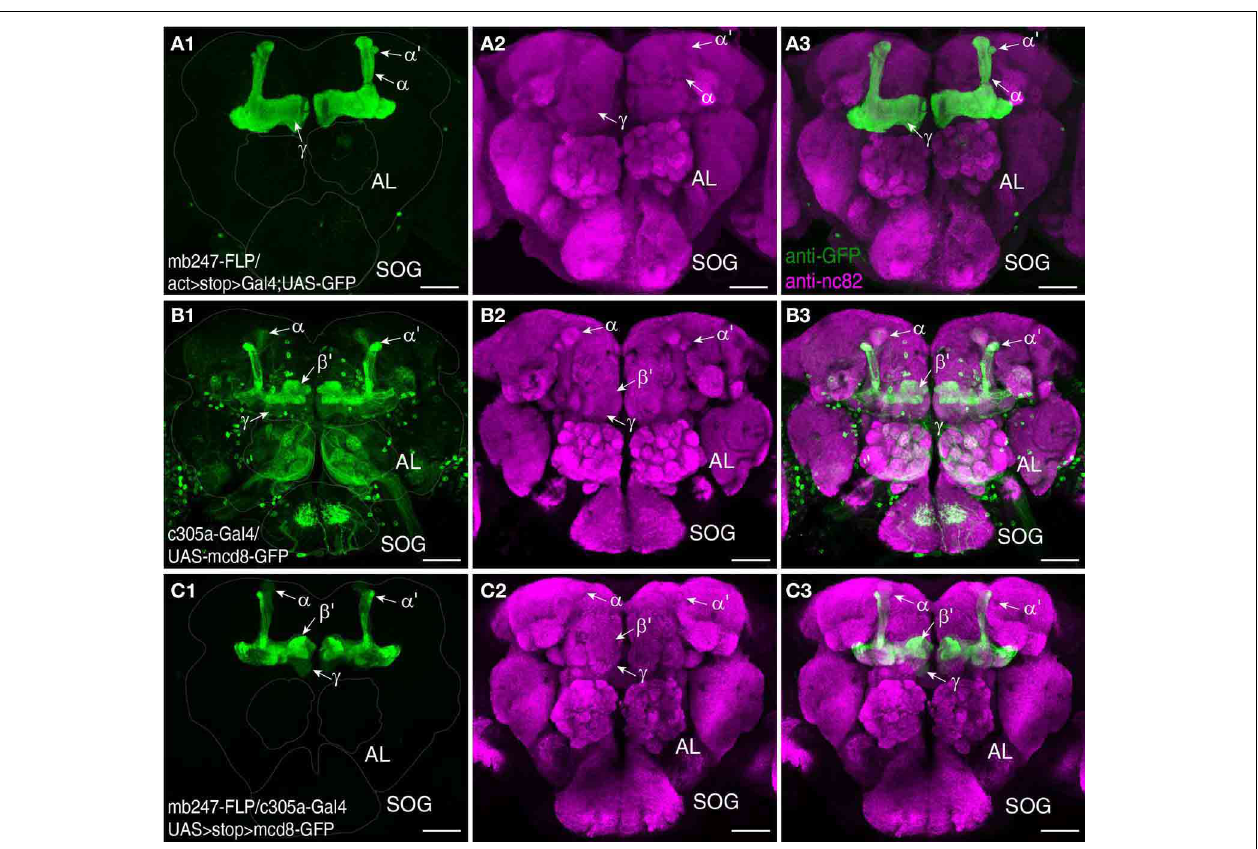
FIGURE 5 | Restriction of transgene expression to Kenyon cells using mb247-flippase. (A) As an indicator for flippase activity a fly strain is used that carries a ubiquitous Act-Gal4 driver, with a FRT-flanked stop cassette preceding the Gal4 driver sequence. The mb247 promoter-induced flippase expression mediatestheexcisionoftheFRT-flankedstopcassetteandcausestranscription ofGal4exclusivelyinthemushroombodies.GFPexpressionisvisualizedusing an anti-GFP antibody (green) (A1) , neuropils are visualized using an anti-bruchpilot antibody (magenta) (A2) . (A3) shows the overlay of (A1,A2) . (B) Expression pattern of c305a-Gal4 visualized by UAS:mcd8-GFP expression labeled by anti-GFP (green) (B1) . Neuropils are visualized using an